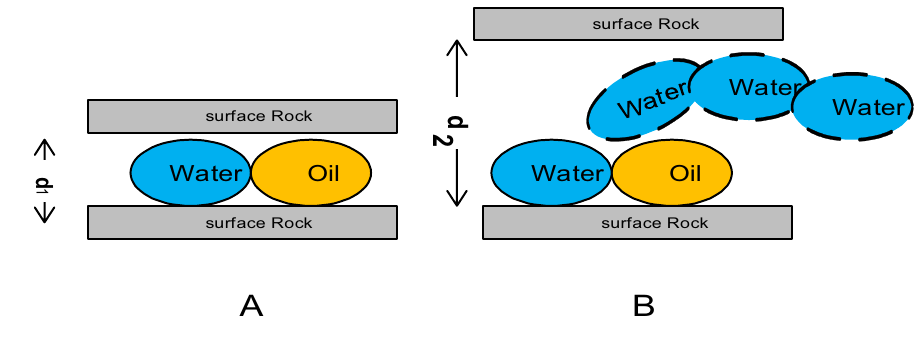
Fig. 1 How the pore diameter relative to the mass of the oil droplet can determine the fate of the oil